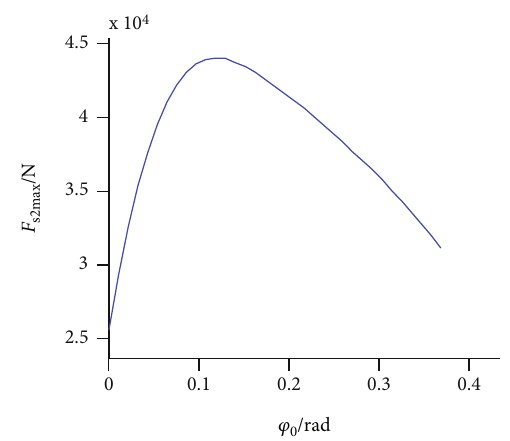
Figure 17: Max force on the secondary strut 2 vs. initial pitch angle.